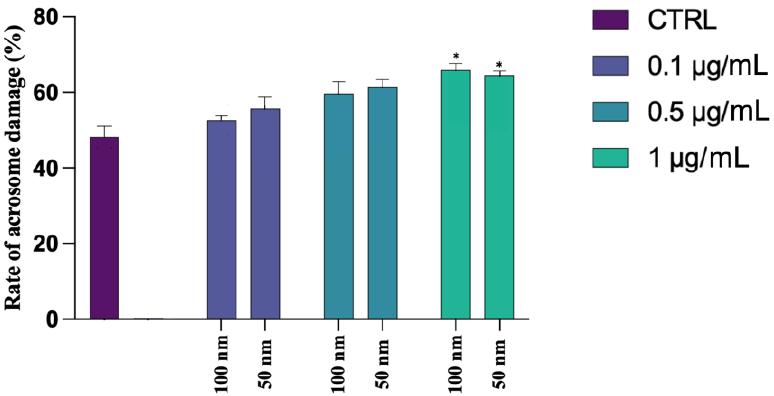
Figure 2. Observation of a casual field of spermatozoa subjected to PNA-FITC test to assess acro- some integrity: ( a ) spermatozoon FITC+ with intact acrosome; ( b ) FITC+ spermatozoon only at the level of the middle region of the head; ( c ) spermatozoa FITC−.